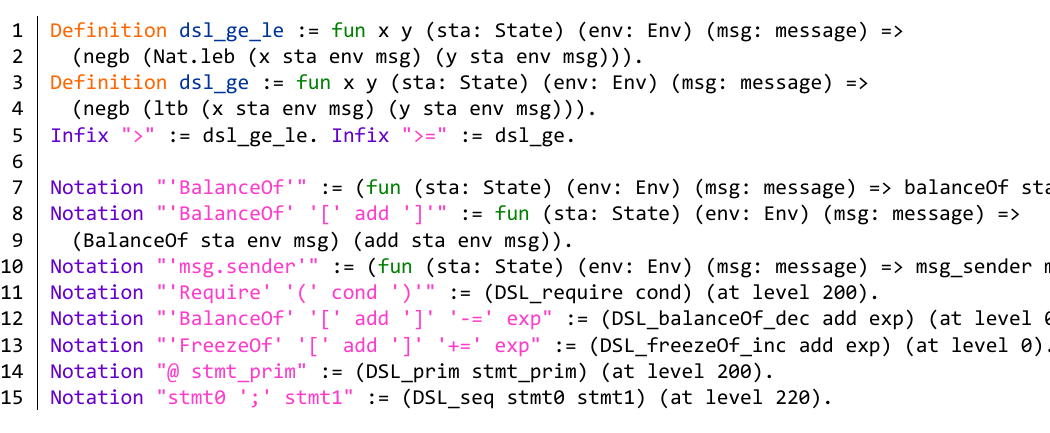
Figure A2. Notations that makes the DSL syntax close to